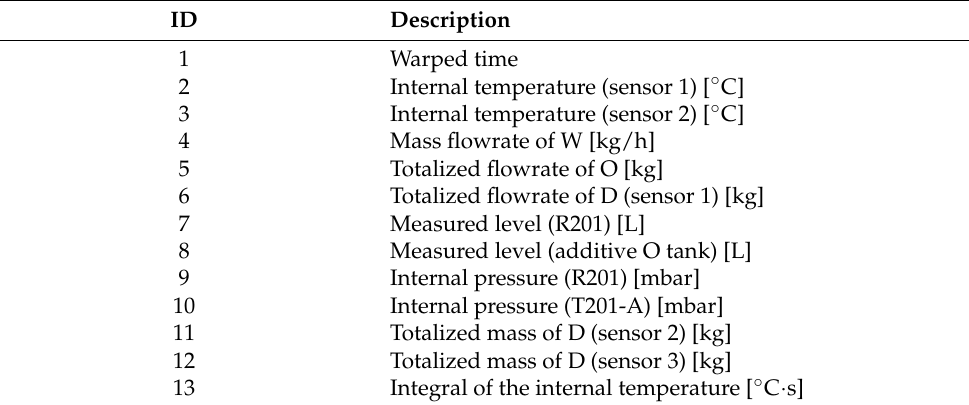
Table A2. List of the process variables analyzed for unit R201.